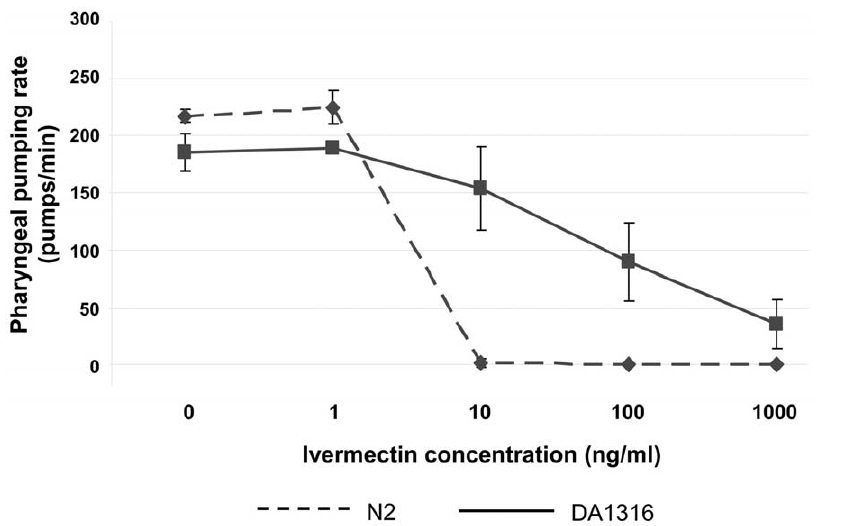
Figure 1. Pharyngeal pumping rate following 4 hr exposure of DA1316 and N2 to 0–1000 ng/ml (1.14 m M) IVM. Whilst strain DA1316 is more resistant to IVM induced pharyngeal paralysis, at concentrations greater than 100 ng/ml (0.1 m M) the pharyngeal pumping rate is significantly reduced. The pharyngeal pumping rates of five worms were counted at each concentration of IVM and the error bars represent the standard deviation.